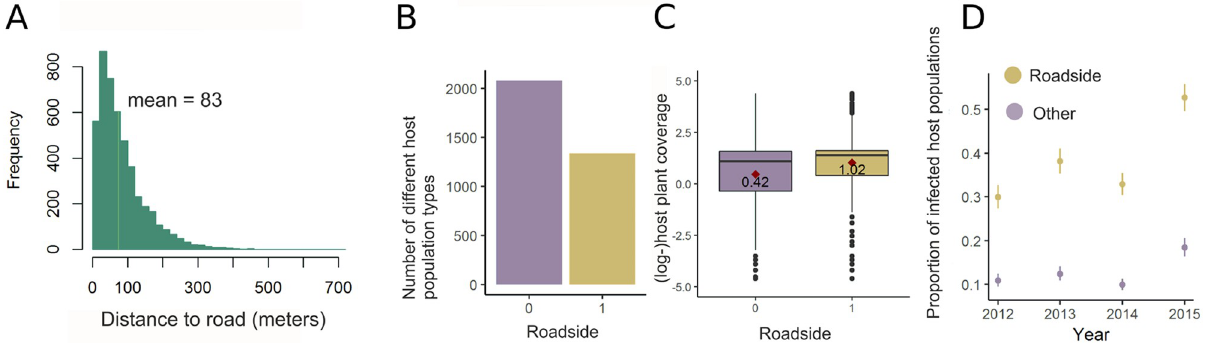
Fig 3. Panel A shows the distribution of distance to road from the gravitational center of the host population, B shows the total counts of roadside and non-roadside populations. C depicts the larger host plant coverages in roadside populations than the other populations and D shows the different infection prevalence between the two types of host